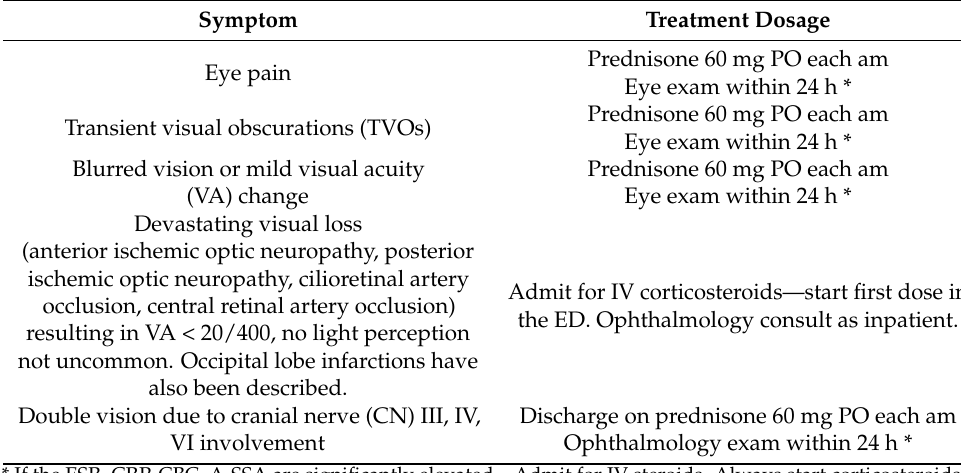
Table 1. Common ocular manifestation of giant cell arteritis and appropriate timeline for consultation and management in the emergency department [5,6].